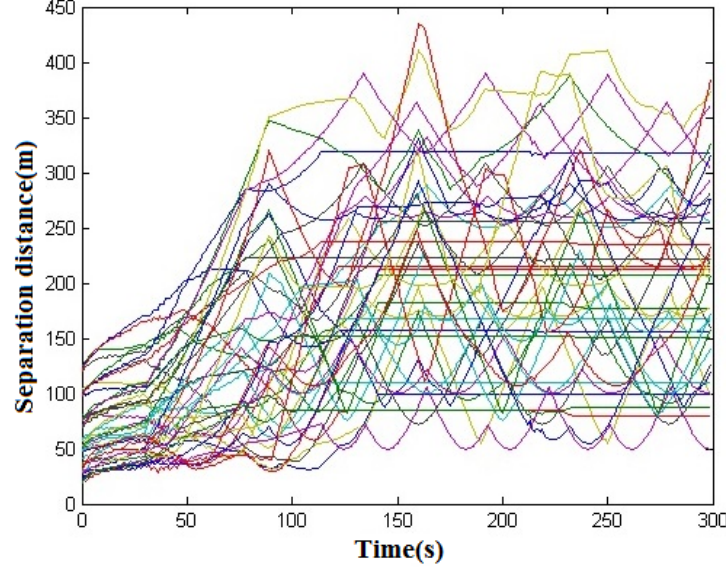
Figure 14. Test 1: Separation distance along horizontal